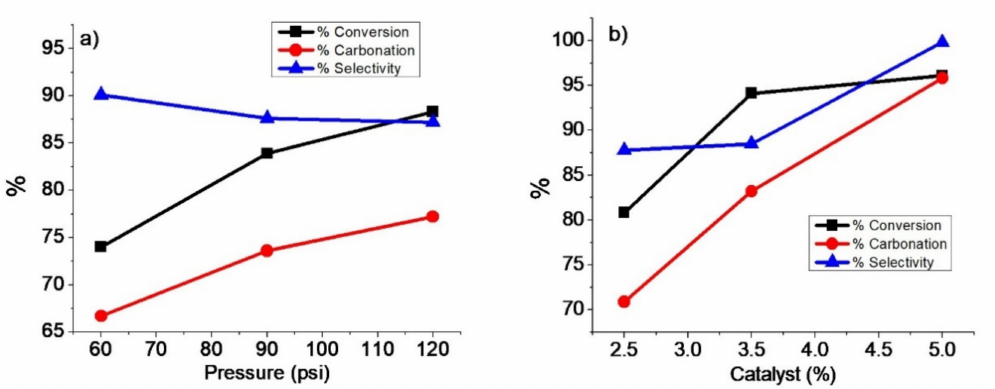
Figure 8. ( a ) Effect of pressure at 90 ◦ C, 3.5% TBAB, and 68 h. ( b ) Effect of catalyst concentration at 120 psi, 90 ◦ C, and 86